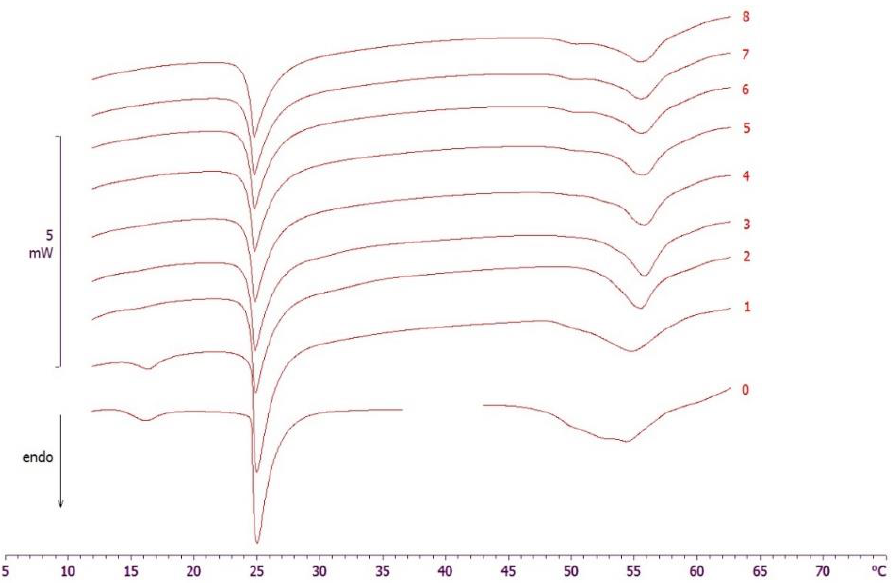
Figure 11. Calorimetric curves, in heating mode, of MLV put in contact with SLN-BXL, at pH 7.4, at increasing incubation time. The numbers on the right side of the curves refer to the calorimetric scans. The curves 0 refer to the samples before contact.